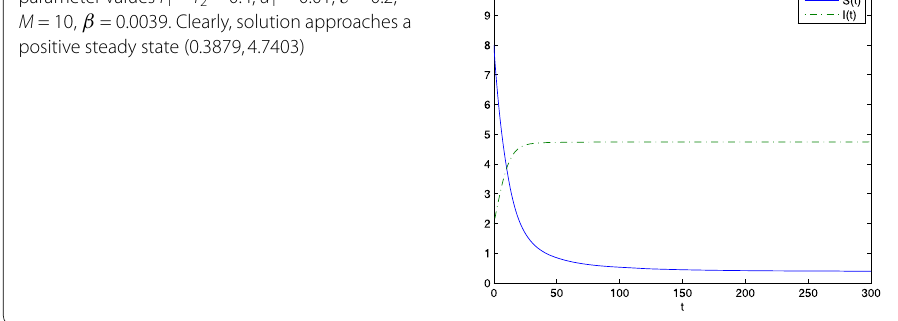
Figure 2 Numerical simulations of system (2) with parameter values r 1 = r 2 = 0.4, d 1 = 0.01, ε = 0.2, M = 10, β = 0.0039. Clearly, solution approaches a positive steady state (0.3879,4.7403)